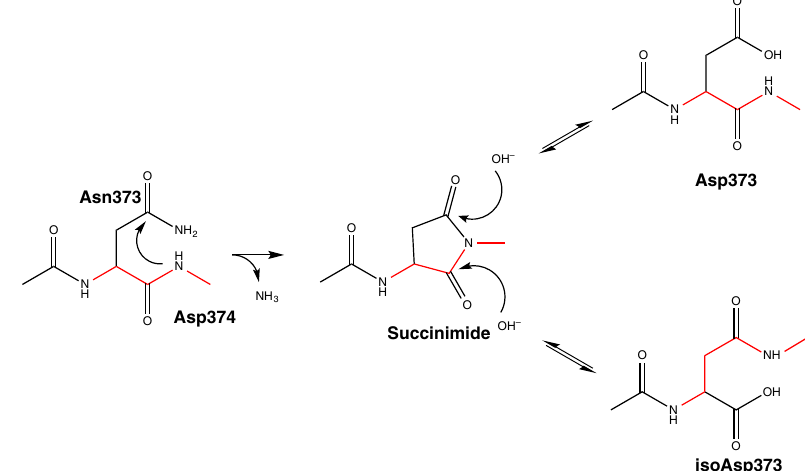
Fig. 3 Deamidation of Asn373 and formation of isoD373. Nucleophilic attack of the side-chain carboxylic acid carbon of Asn373 by the backbone nitrogen of Asp374 leads to formation of a reactive succinimide derivative via a nucleophilic acyl substitution. The unstable succinimide reacts with water molecules to yield either isoAsp373 (isopeptide bond) or Asp373 (normal peptide bond). Red bonds highlight the peptide